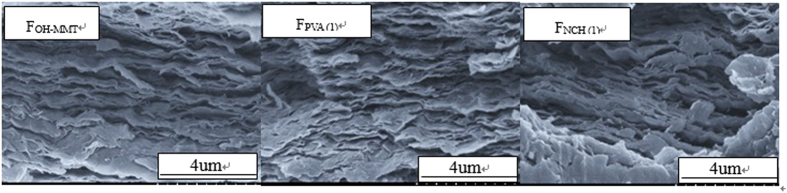
SEM photos of the fracture of the FQH-MMT, FNCH(1), and FPVA(1) films.